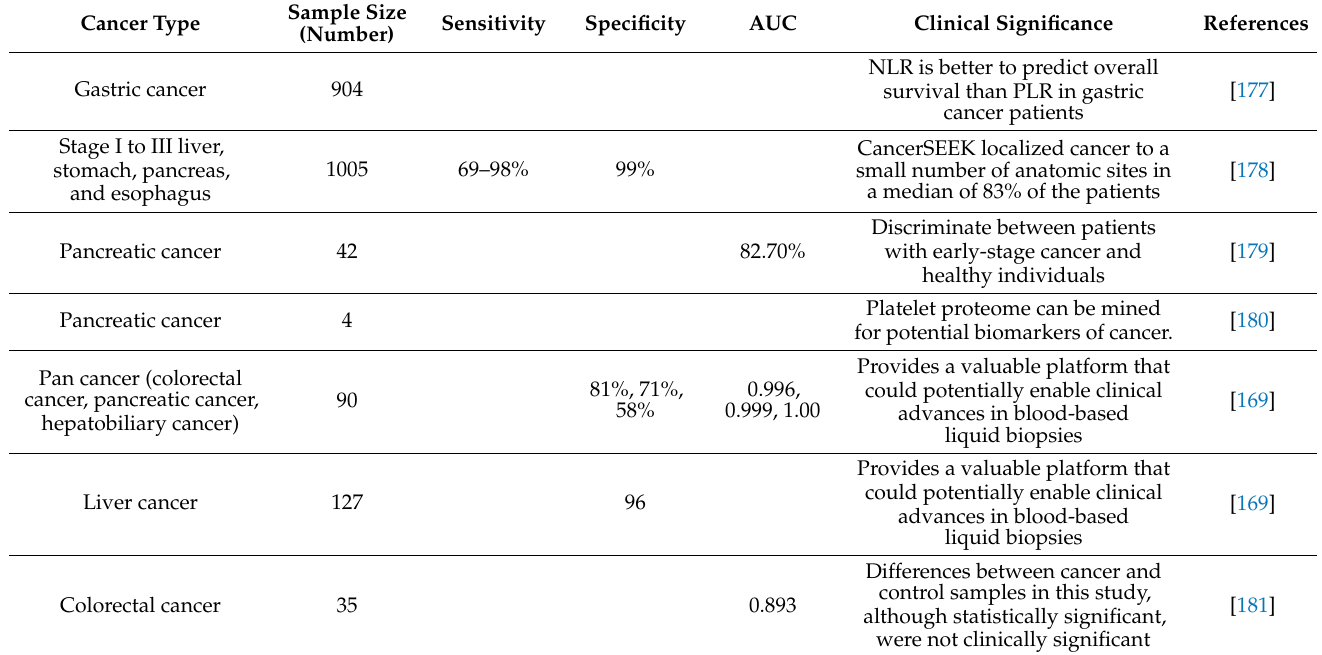
Table 4. Clinical relevance of tumor-educated platelets in